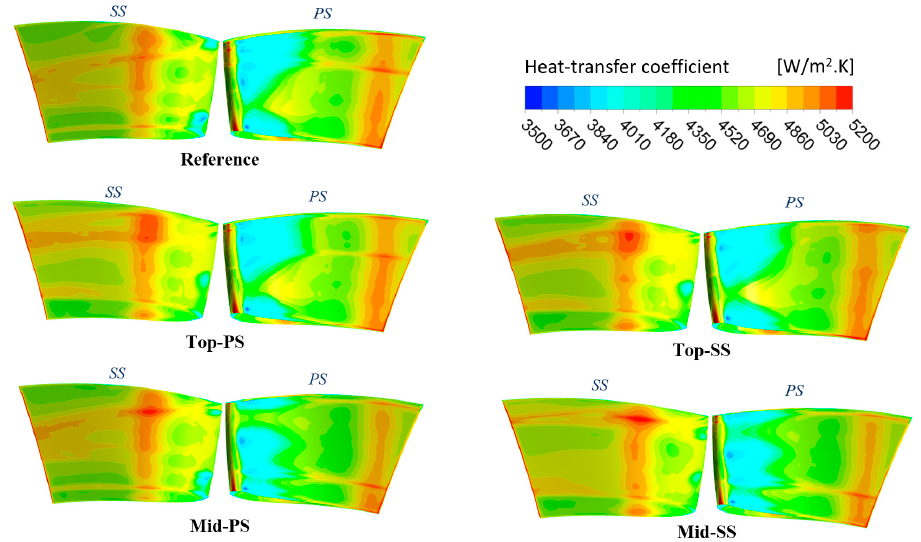
Figure 17. Heat-transfer coefficient distribution on the S 2 vane surface under different damaged- blade conditions.